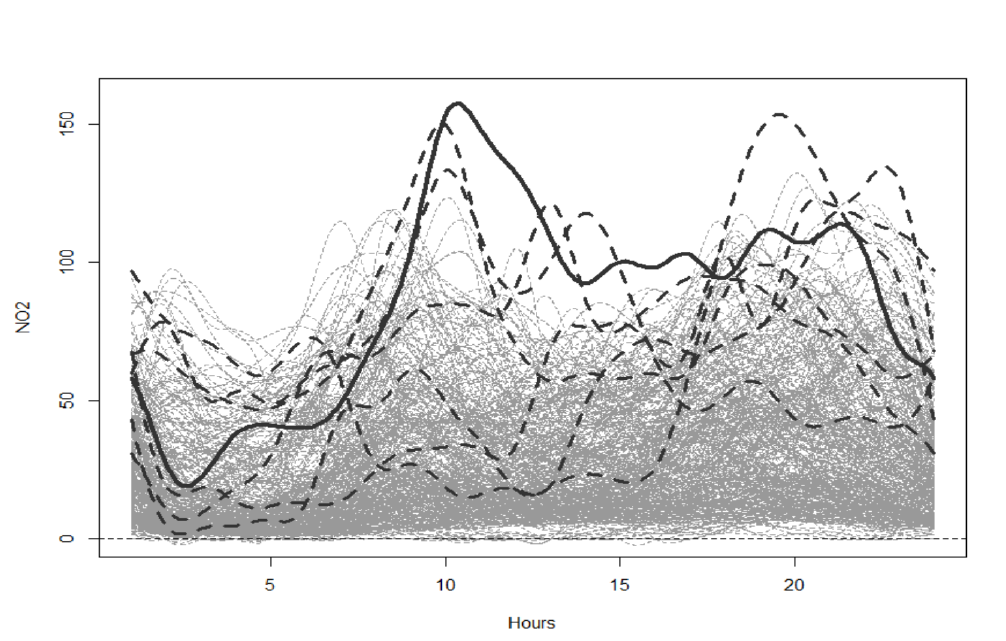
Figure 14. NO 2 functional data; and in the dark grey and dotted line, the functional outliers detected. Highlighted is the 11th day which is also an outlier. Software: R-programming